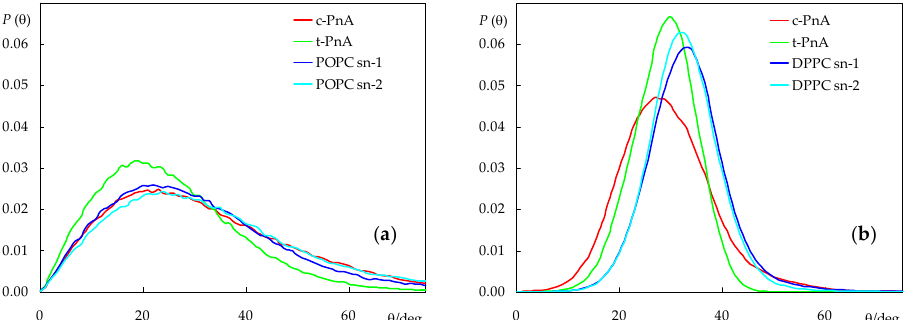
Figure 6. Long axis (defined as the vector from the terminal to the first C atom) tilt angle distributions of the parinaric acid and lipid acyl chains in POPC ( a ) and DPPC ( b ). Lipid distributions refer to probe-free simulations.